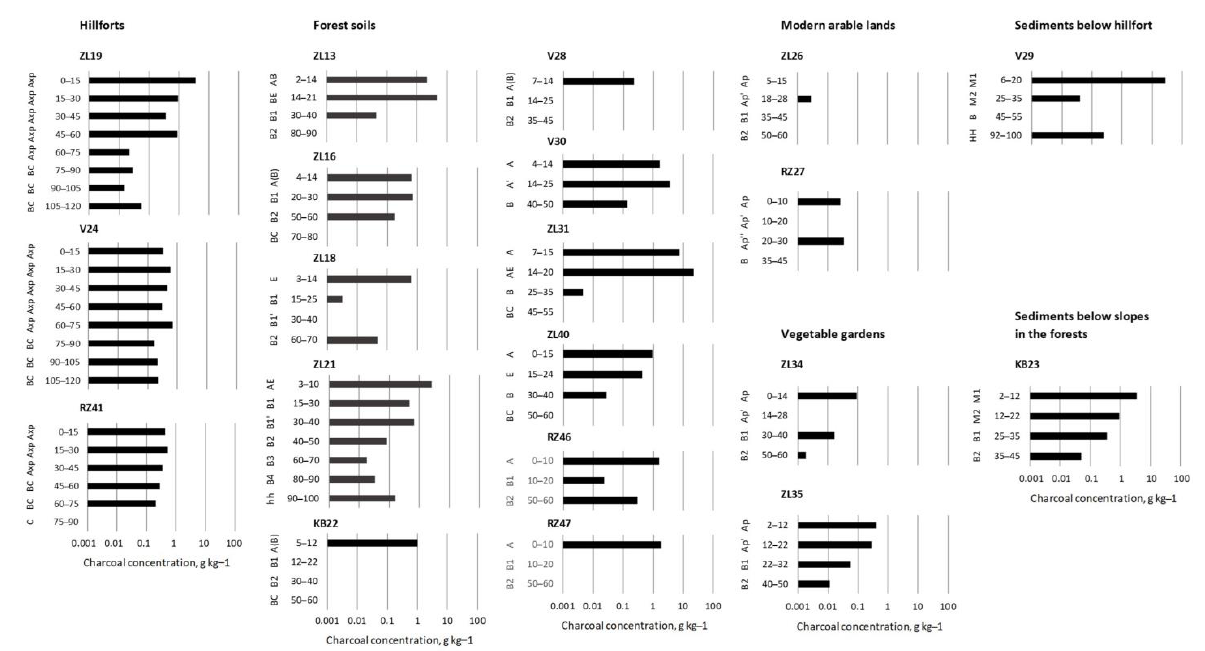
Figure 3. Charcoal concentration in soil of different land types. Table 2. Mean charcoal concentration and standard error (g kg−1 ) in soils of different land types.